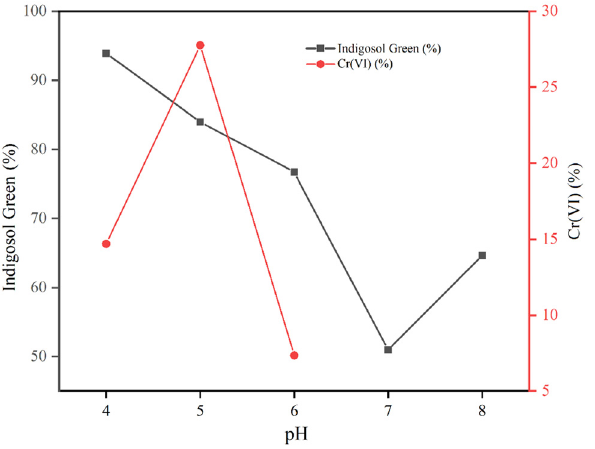
Figure 8: E ff ect of mass of Fe 3 O 4 /TiO 2 /AC for the removal of indigisol green and Cr ( VI ) from aqueous solutions.